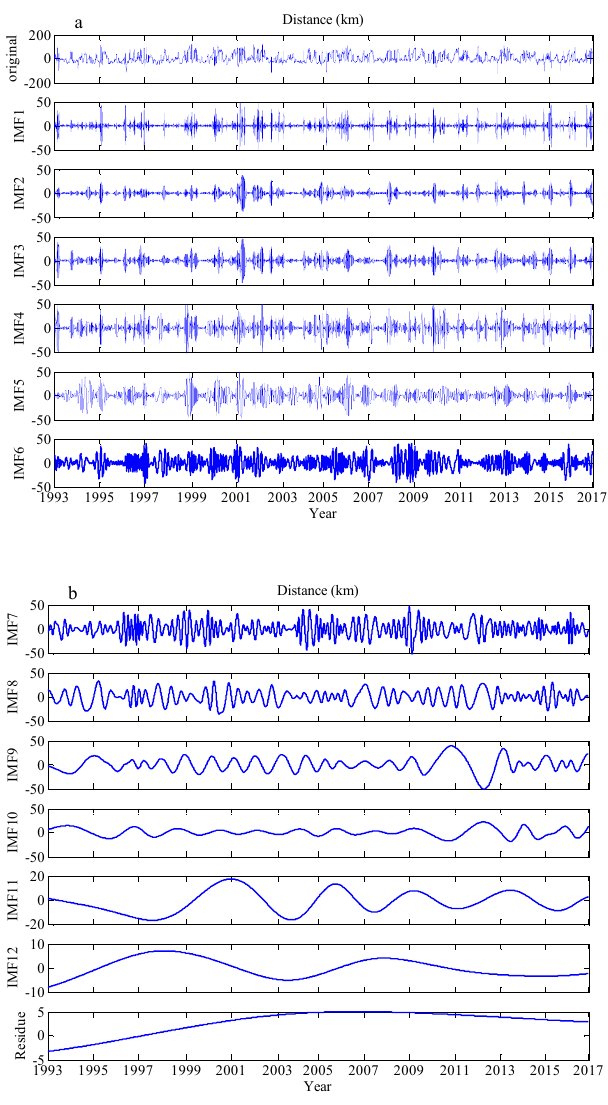
Figure 4. IMF components and the residue (unit: km) obtained from the time series of the distance away from the mean axis location along Transect A using empirical mode decomposition (EMD) method. ( a ) The time series of the distance and IMF1-IMF6, ( b ) IMF7-IMF12 and the residue. The error bars in Figure 5a represent the mean value and STD of the frequency and amplitude